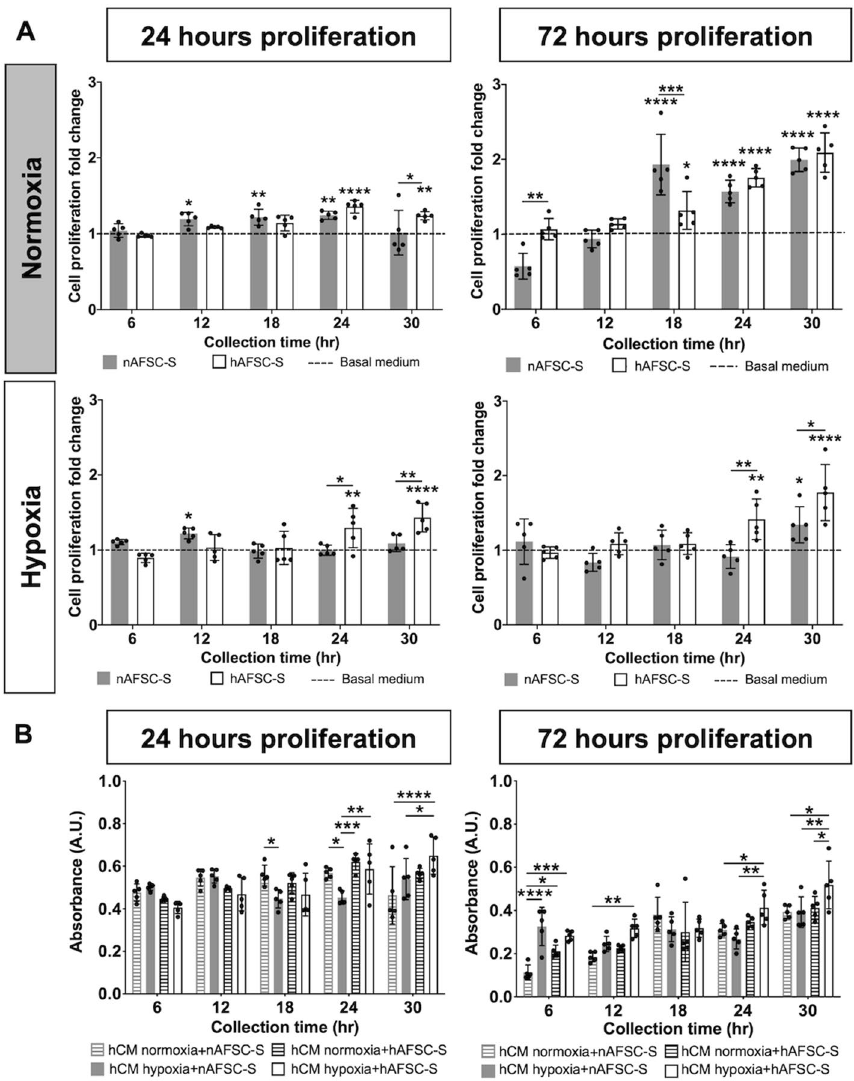
Figure 4. Comparison of human cardiomyocyte (hCM) proliferation. Comparison of the MTS tetrazolium compound reduction in a colorimetric assay to asses hCM proliferation cultured for 24 or 72 h in normoxic (Normoxia) and hypoxic (Hypoxia) culture conditions with amniotic fluid stem cells secretome (AFSC-S) collected from normoxic (nAFSC-S) or hypoxic (hAFSC-S) conditions collected at 6 to 30 h. ( A ) Cell proliferation fold change evaluation of recorded values normalized to hCM proliferation values in control basal medium (basal MEMα; dashed line) and ( B ) absolute absorbance values cross parameter comparison. Data are expressed as means ± SD. n = 5. * above a bar graph indicates statistical significance between AFSC-S group and basal MEMα group. * above a line indicates statistical significance between nAFSC-S and hAFSC-S group. * p < 0.05, ** p < 0.01, *** p < 0.001, **** p < 0.0001 by two-way ANOVA followed by Tukey’s post hoc